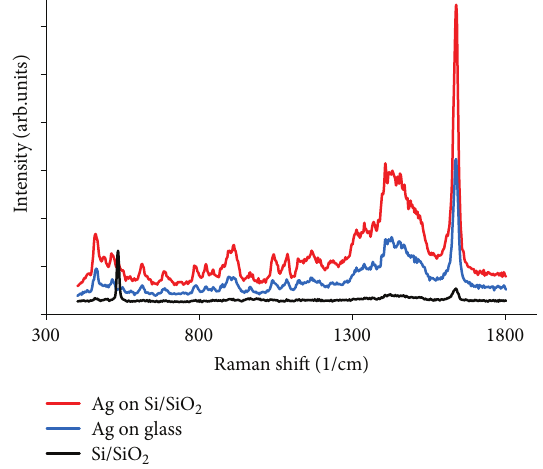
Figure 10: SERS spectra of MB adsorbed on an 8nm thick Ag nanostructures on an oxidized Si wafer (red curve; the oxide thickness is 60nm) and on glass (blue curve). A 2nm thick adhesion layer of Ti was used in both samples. The deposition was done at 𝛼 = 70 ∘ with rotation. The black curve is the spectrum of MB on Si/SiO 2